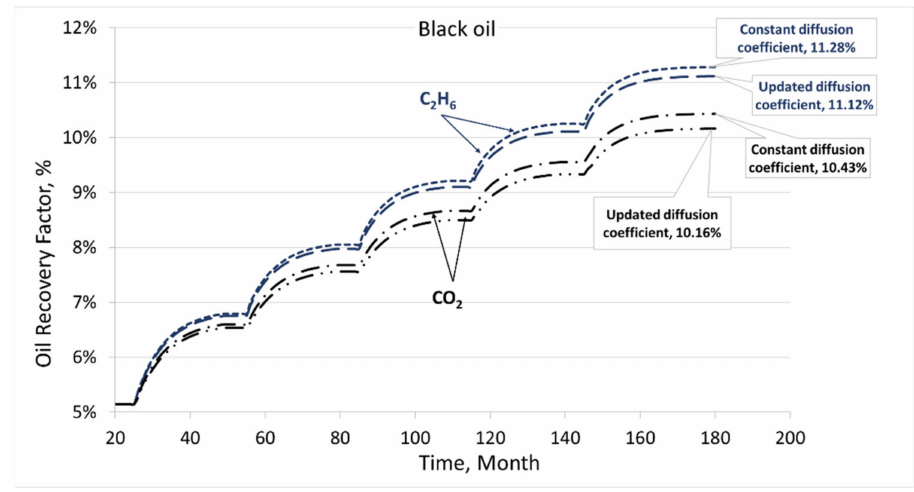
Figure 11. Impact of constant diffusion coefficients throughout the production period for C 2 H 6 injection in the black oil system.